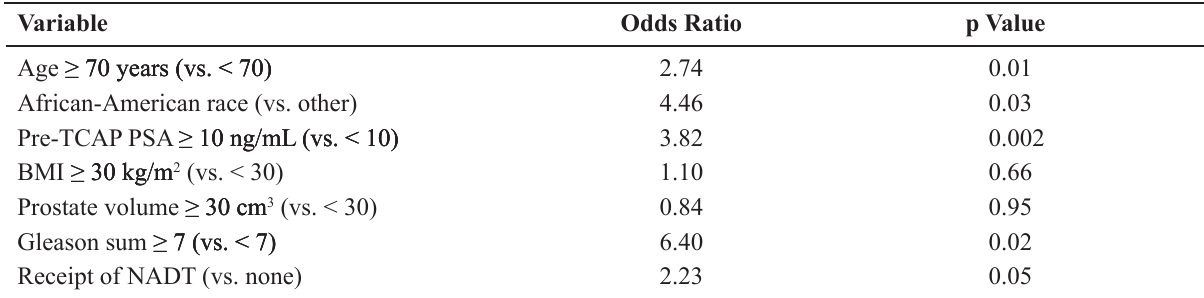
Table 5 – Logistic regression analysis for predicting disease-recurrence utilizing categorical variable modeling.